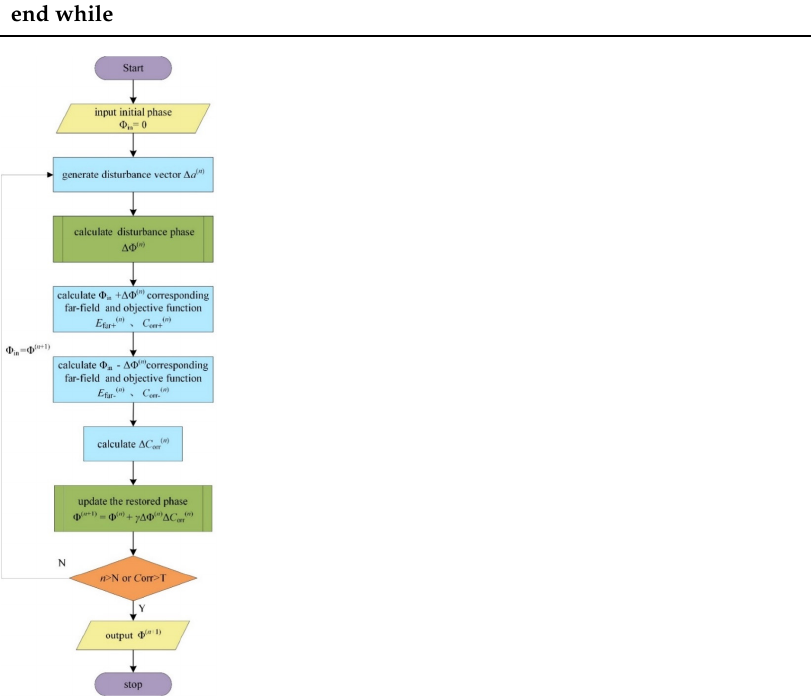
Figure 2. Flow chart of wavefront reconstruction with the SPGD algorithm. 3. Numerical Simulation To investigate the performance of the FBPM-SHWFS, a series of simulations are exe- cuted. The key parameters of the Shack–Hartmann wavefront sensor in the simulation are shown in Table 1. Table 1. Key parameters of the FBPM-SHWFS. Parameters